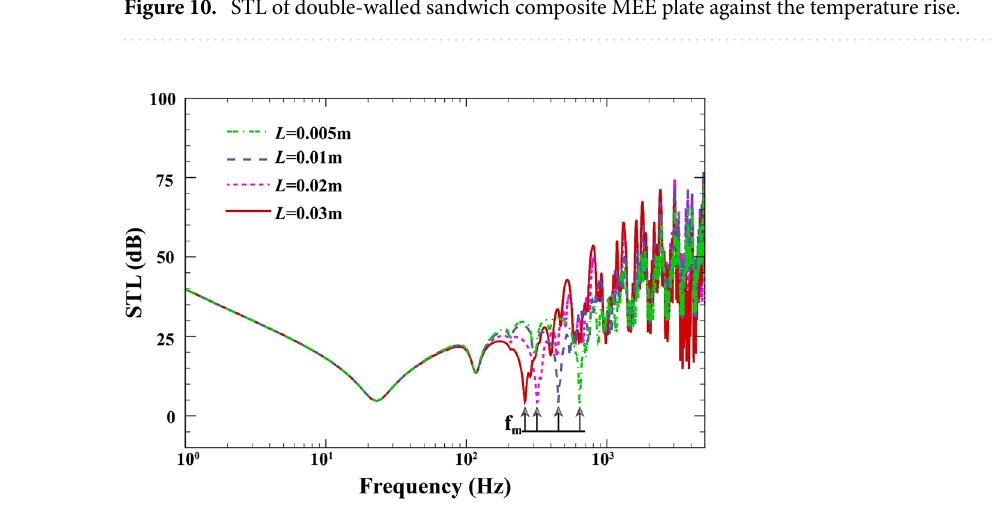
Figure 11. STL of double-walled sandwich composite MEE plate against the air cavity depth.